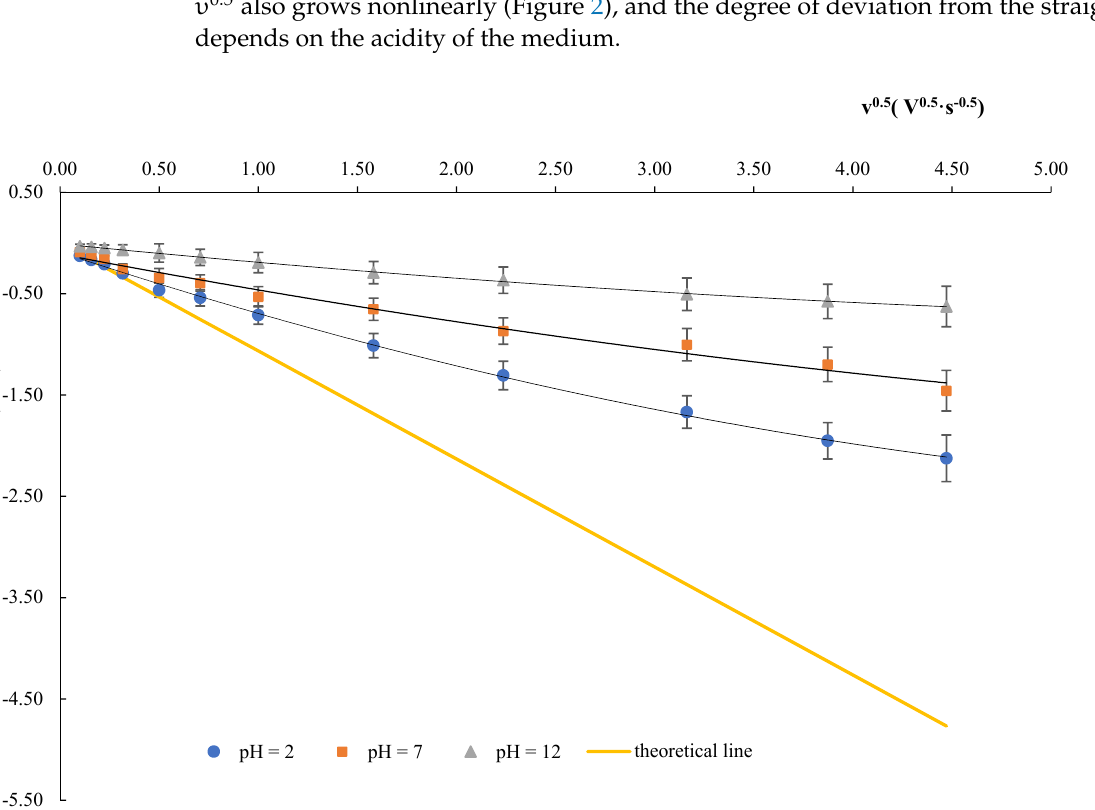
Figure 2. Change in the current of the reduction peak of 5 mM compound 1a from υ 0.5 in the BR buffer solution at a pH of 2, 7, and 12 and the theoretically calculated current level according to the Rendles–Shevchik equation for irreversible electrochemical reactions (n = 6e). Potentials were measured relative to Ag/AgCl/KCl sat .